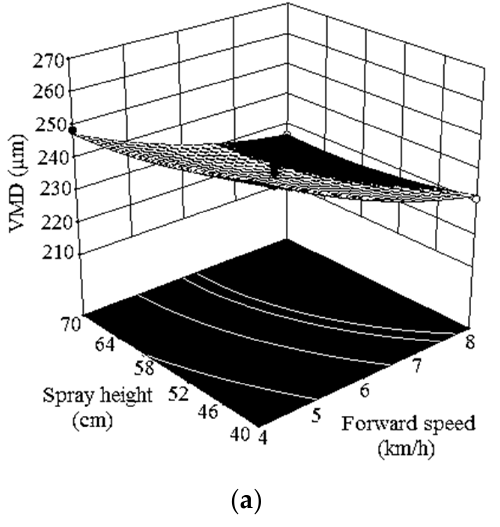
Figure 11. Three-dimensional surface map for coverage percentage: ( a ) interaction effect of forward speed and spray height at 5 bar pressure; ( b ) interaction effect of forward speed and spray pressure at 55 cm height; ( c ) interaction effect of spray height and spray pressure at 6 km/h speed.